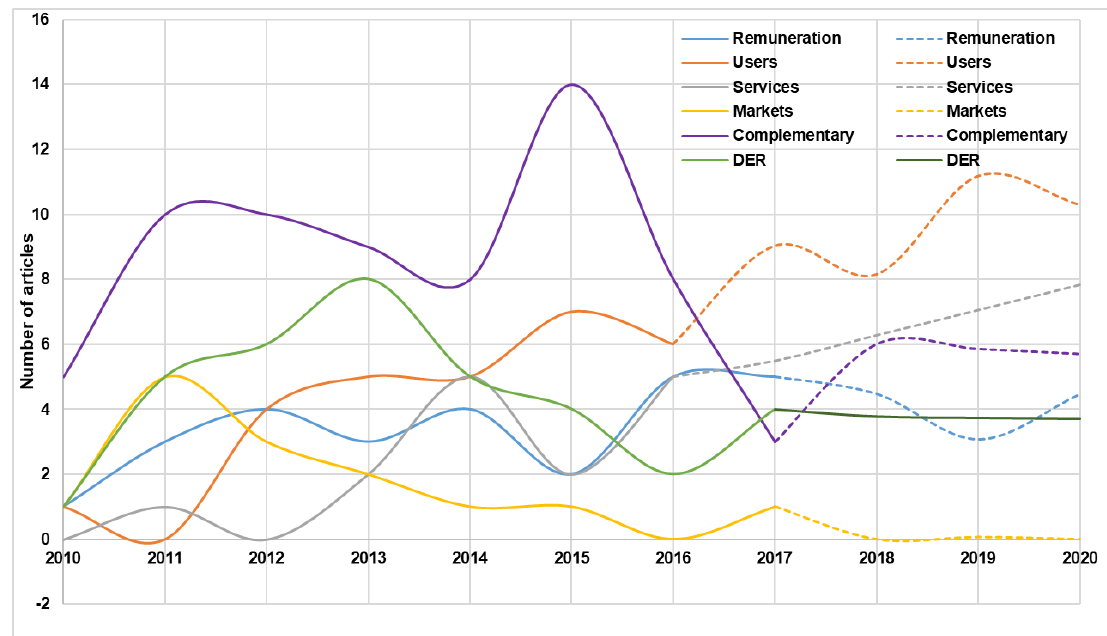
Figure 3. Trends and forecast of DR.